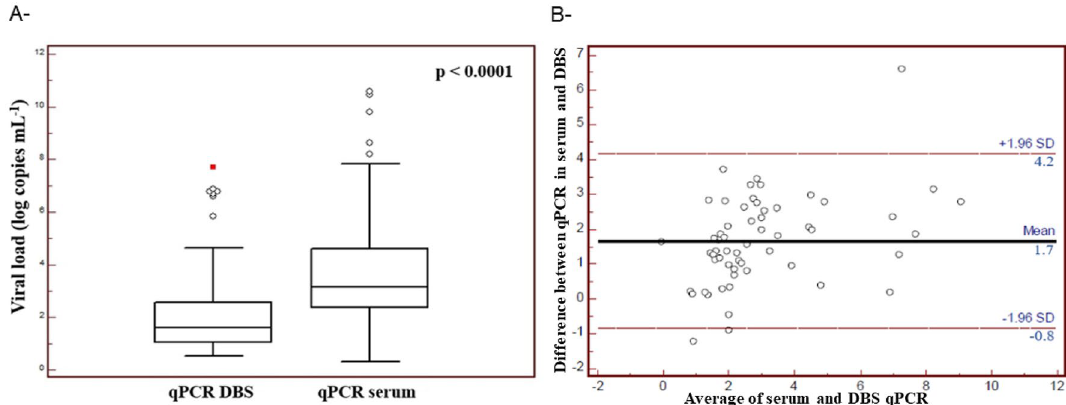
Figure 1. Quantitative analyses of HBV viral loads (log copies/mL) in serum and DBS samples (qPCR). ( A ) Box-Plot of HBV DNA viral load (log copies/mL) for paired DBS and serum using qPCR. The outliers are represented as the black circles. P < 0.0001 (Mann–Whitney Rank Sum Test). ( B ) Bland–Altman Plots resulting from the pairwise comparison of HBV viral load in serum and DBS samples in qPCR. The mean difference (black line at center) is presented as a function of the average viral load of the assays performed in two different samples. Upper and lower limits of agreement (upper and lower pink lines, respectively) defined by mean HBV viral load difference ± 1.96 Standard Deviation (SD). qPCR Variable